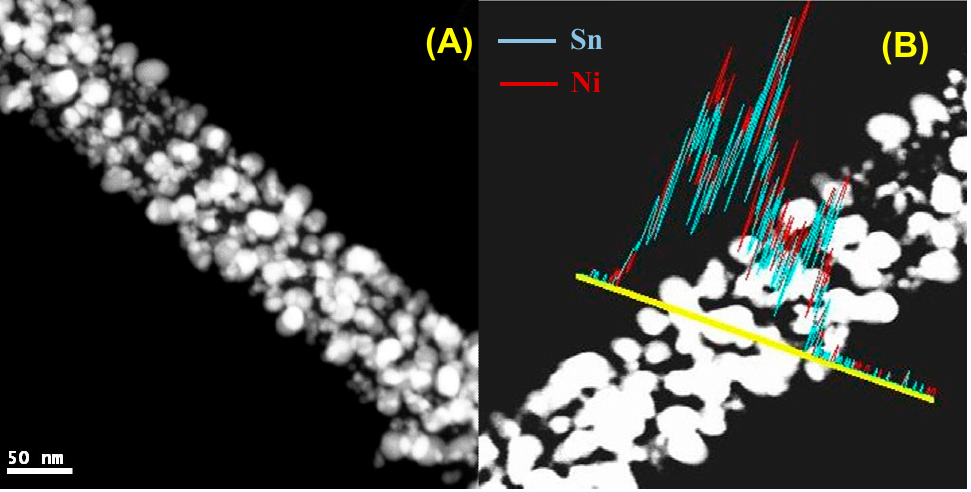
Figure 3. TEM image ( A ), and EDX line scan ( B ) for the prepared Sn-incorporated nanofibers; 10 wt % and 850 °C calcination temperature.